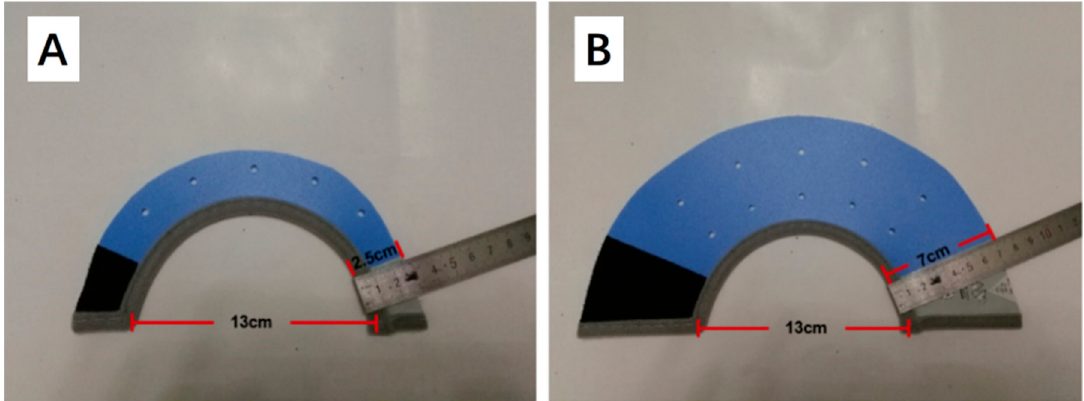
Figure 1. Narrow collar and wide collar used for rabbits. ( A ) Narrow collar (2.5 cm wide); ( B ) Wide collar (7.0 cm wide).